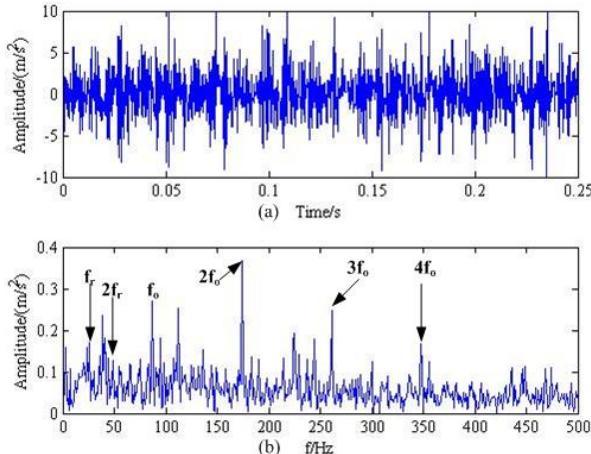
Figure 5. Results obtained by the proposed method, (a) Reconstructed signal in time ‐ domain by the proposed method; (b) Reconstructed signal in frequency ‐ domain by the proposed method.